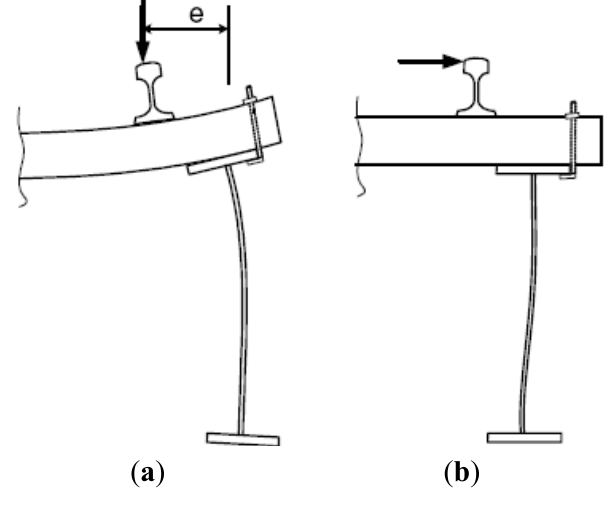
Figure 10. Schematic figure showing the deformations induced in a bridge girder as a result of: ( a ) Bending deformation due to rail eccentricity; and ( b ) Transverse